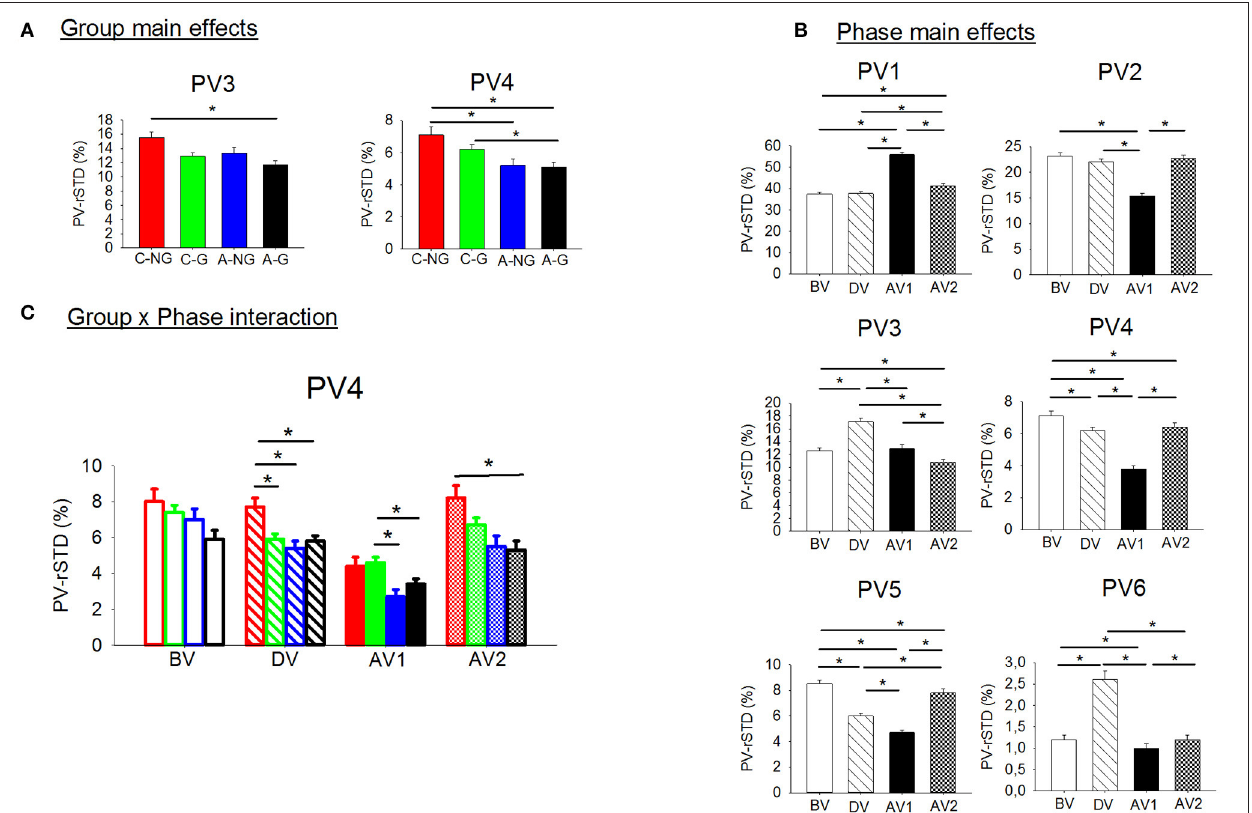
FIGURE 4 | (A) Significant group main effects in the PVs (principal velocities). Means and standard deviations were plotted by group (children non-gymnasts, C-NG, children gymnasts, C-G, adults non-gymnasts, A-NG, and adults gymnasts, A-G); (B) significant phase main effects in the PV. Means and standard deviations values were plotted by phase (BV, before vibration; DV, during vibration; AV1, after vibration early phase; AV2, after vibration late phase); and (C) significant group x phase interactions in the PVs. (*) indicates significant differences in the post-hoc analyses.